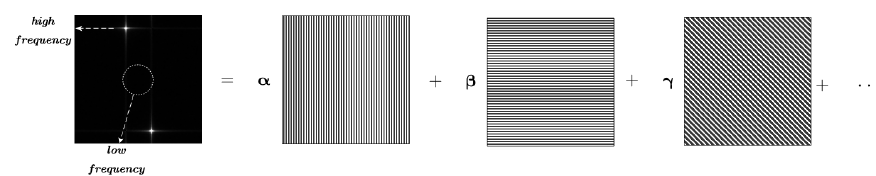
Figure 3. Image of texture features of the data